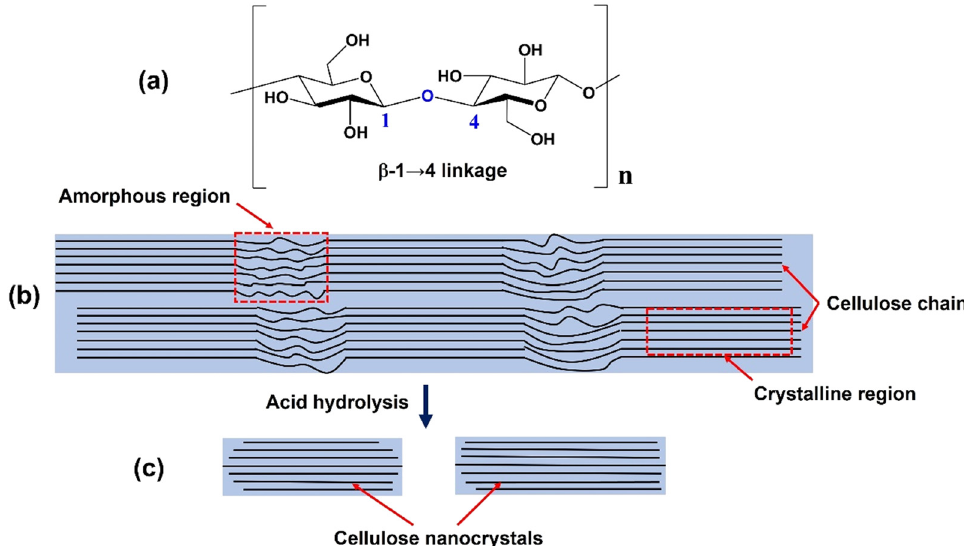
Figure 1: Schematics of ( a ) repeating unit of cellulose chain with the directionality of the 1 → 4 linkage, ( b ) idealized cellulose micro fi bril with one of the suggested con fi gurations of the crystalline and amorphous regions, and ( c ) cellulose nanocrystals after acid hydrolysis dissolved the disordered